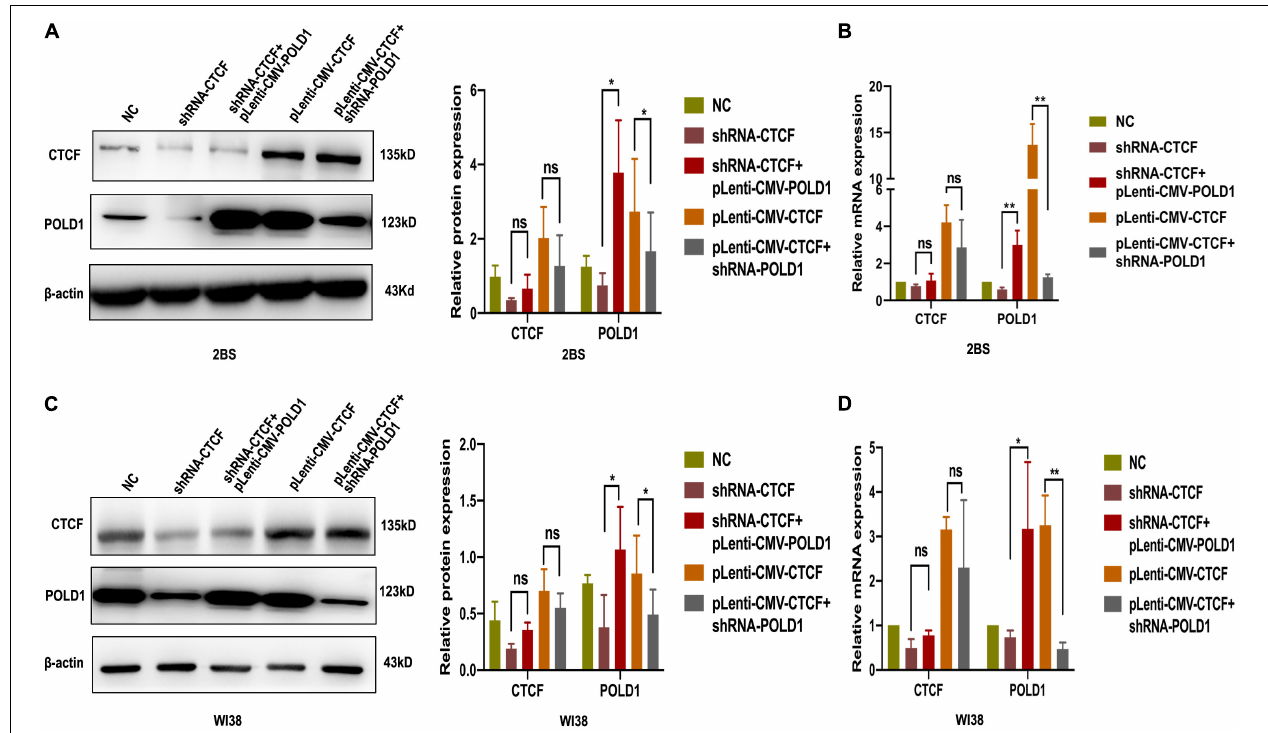
FIGURE 5 | DNA polymerase delta 1, catalytic subunit (POLD1) rescued the effect of CCCTC-binding factor (CTCF) on POLD1 expression. (A,C) Protein expression of POLD1 and CTCF in 2BS (A) and WI38 cells (C) . (B,D) mRNA expression of POLD1 and CTCF in 2BS (B) and WI38 (D) cells. Data were compared by Student’s t -test, and data are shown as the mean ± SEM, with three independent experiments in each group. * P < 0.05, ** P <